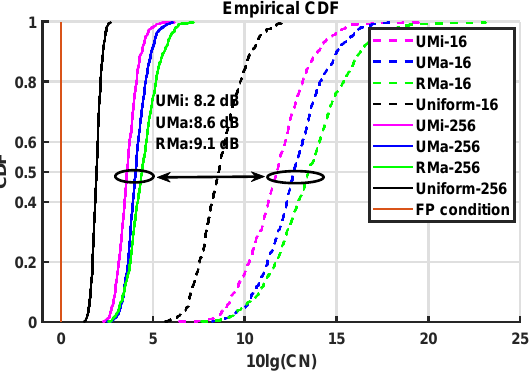
Figure 7. Condition numbers in UMi, UMa and RMa scenarios with different antenna configurations.